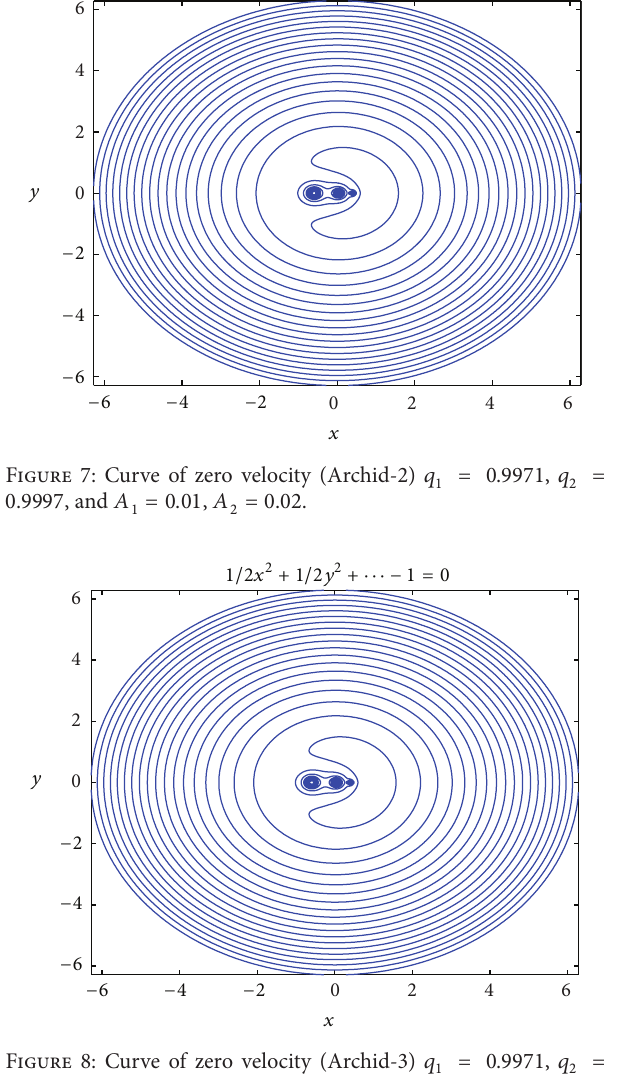
Figure 8: Curve of zero velocity (Archid-3) 𝑞 1 = 0.9971 , 𝑞 2 = = 0.1 , 𝐴 = 0.2 0.9997 , and 𝐴 1 2